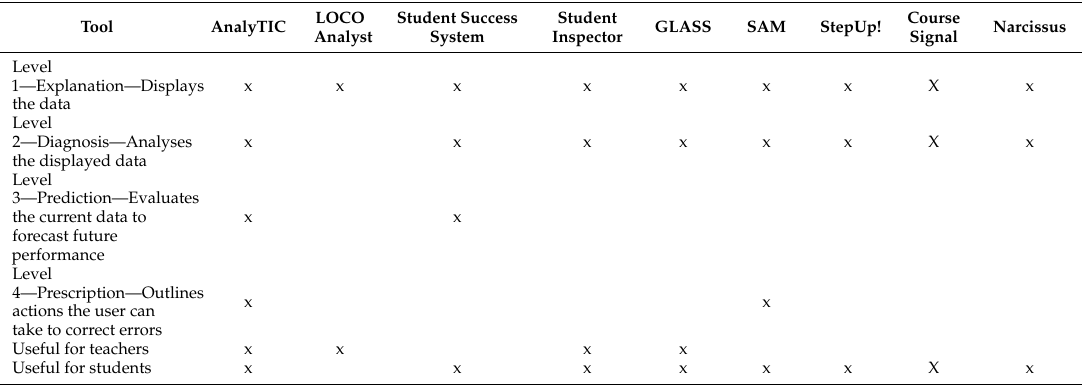
Table 3. Comparison of features between learning analytics